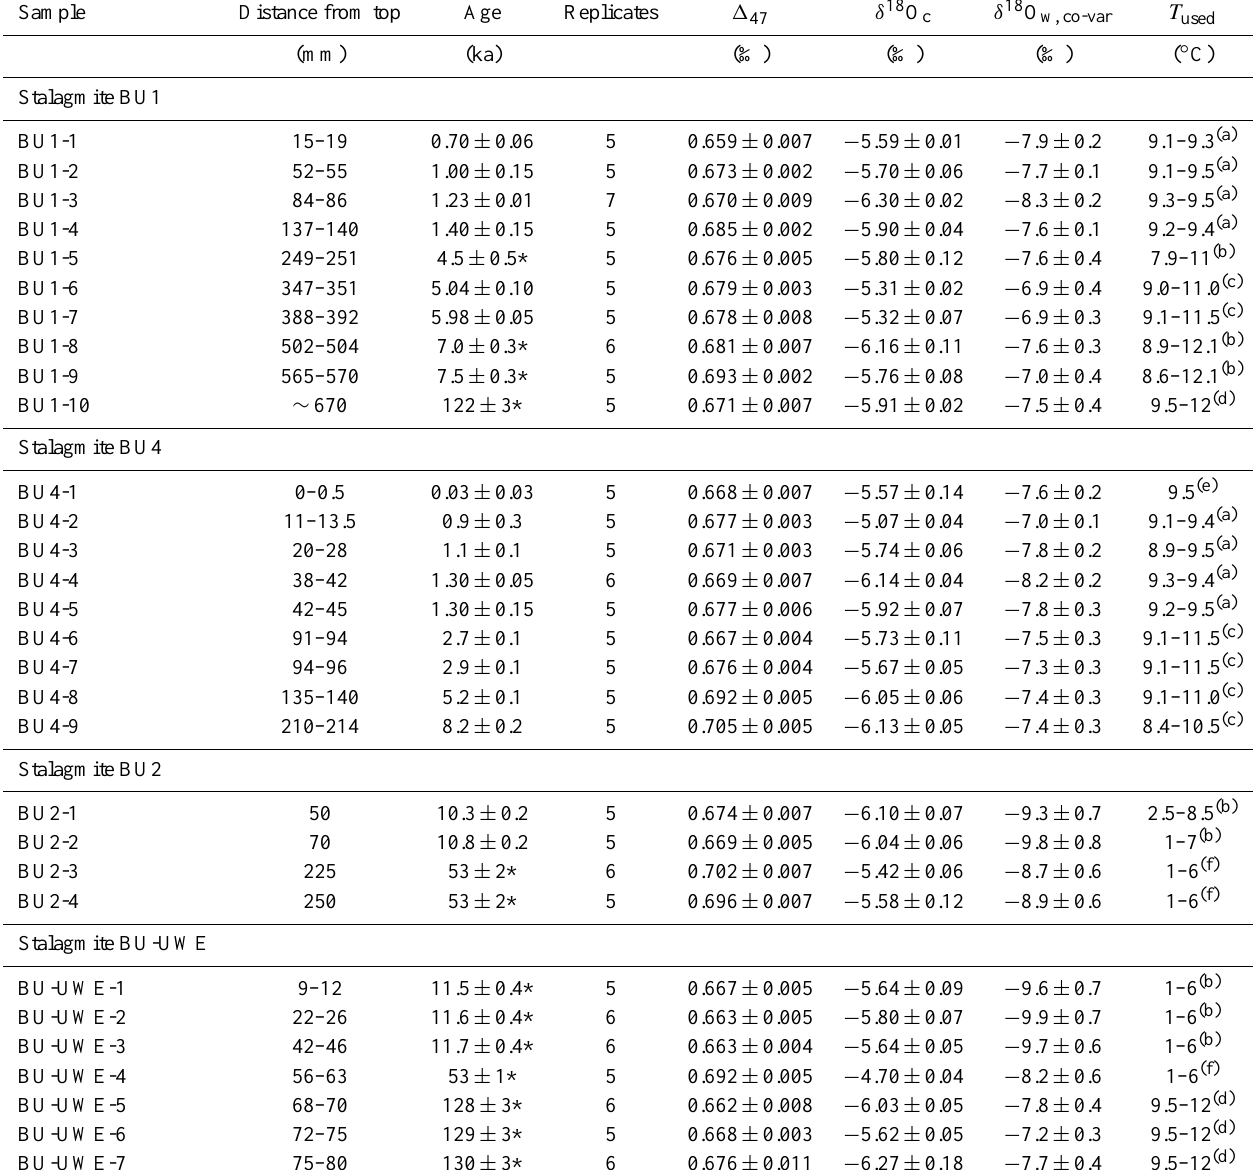
Table 2. Clumped isotope 1 47 , calcite δ 18 O c (VPDB) and reconstructed drip-water δ 18 O w, co-var (VSMOW) in Bunker Cave stalagmites. “Distance from top” refers to the sample position with respect to the top of the stalagmite. Ages are the result of an age model based on U-Th measurements (Fohlmeister et al., 2012; ages marked with an asterisk refer to unpublished data). T used is the independent temperature estimate derived from different sources and independent